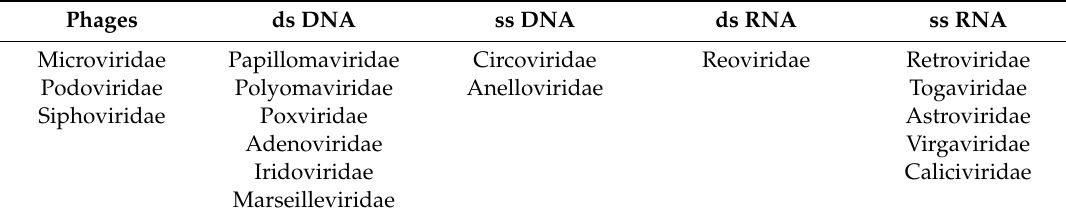
Table 3. Viral communities identified in the mammalian